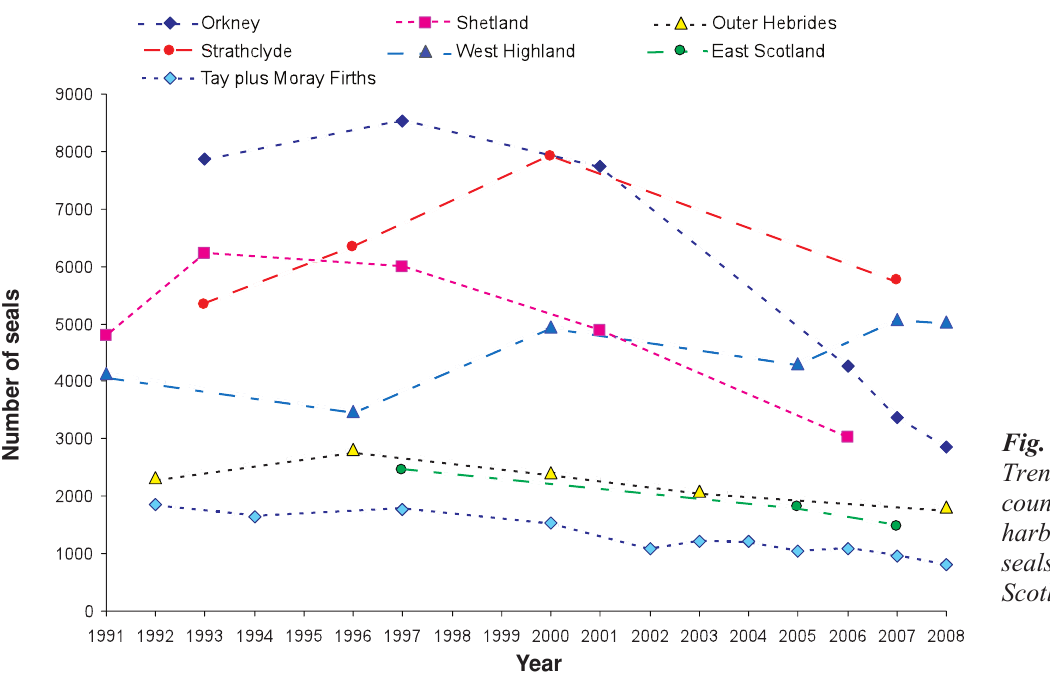
Fig. 2. Trends in counts of harbour seals around